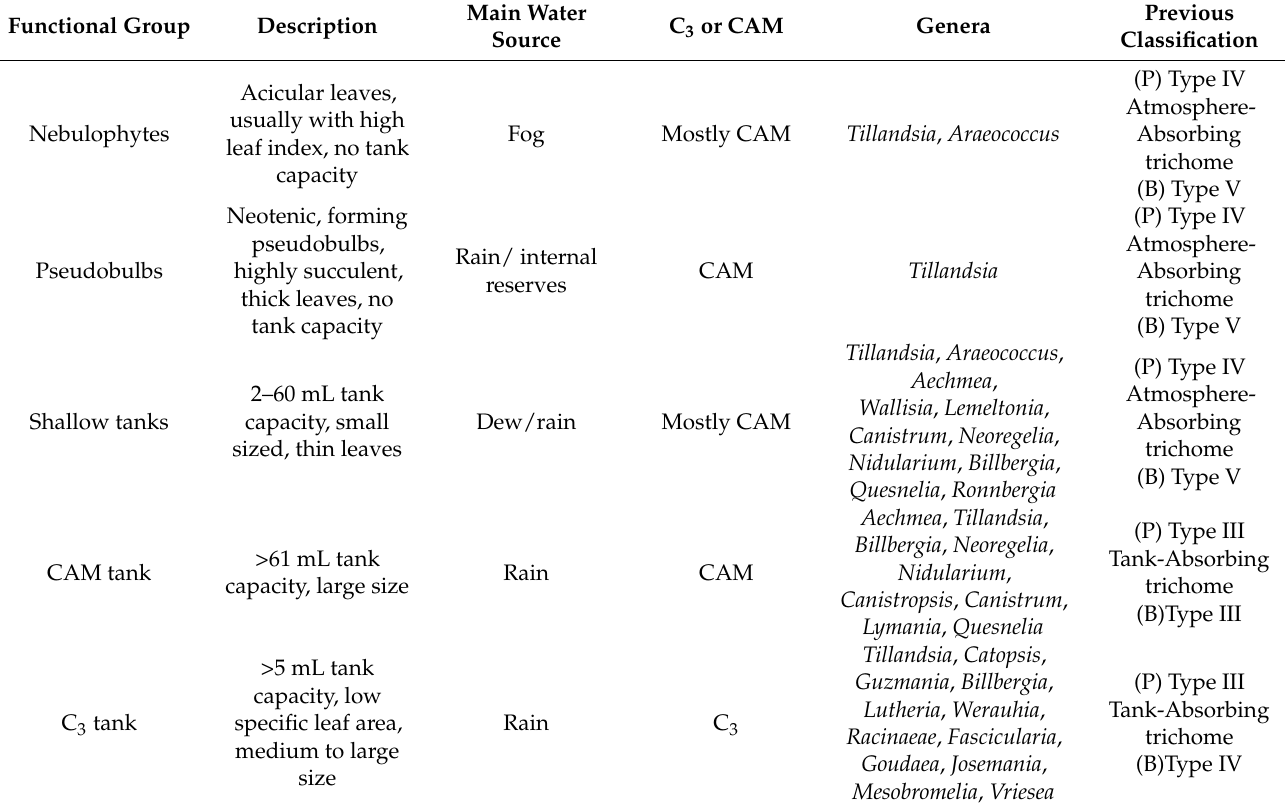
Table 3. Functional groups, description of the main traits that define them, main water source, photo- synthetic pathway, genera, and corresponding previous classifications. Water sources information was taken from previous studies; genera are listed from higher to lower abundance according to the species analyzed in this study. Previous classification refers to (P) Pittendrigh [17] and (B) Benzing